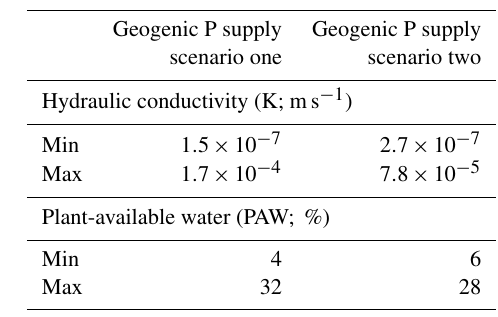
Table 4. Minimum and maximum soil hydraulic conductivity for areas coincident with the P gap areas of each geogenic P supply scenario, for the N-unlimited AR scenario (Fig.